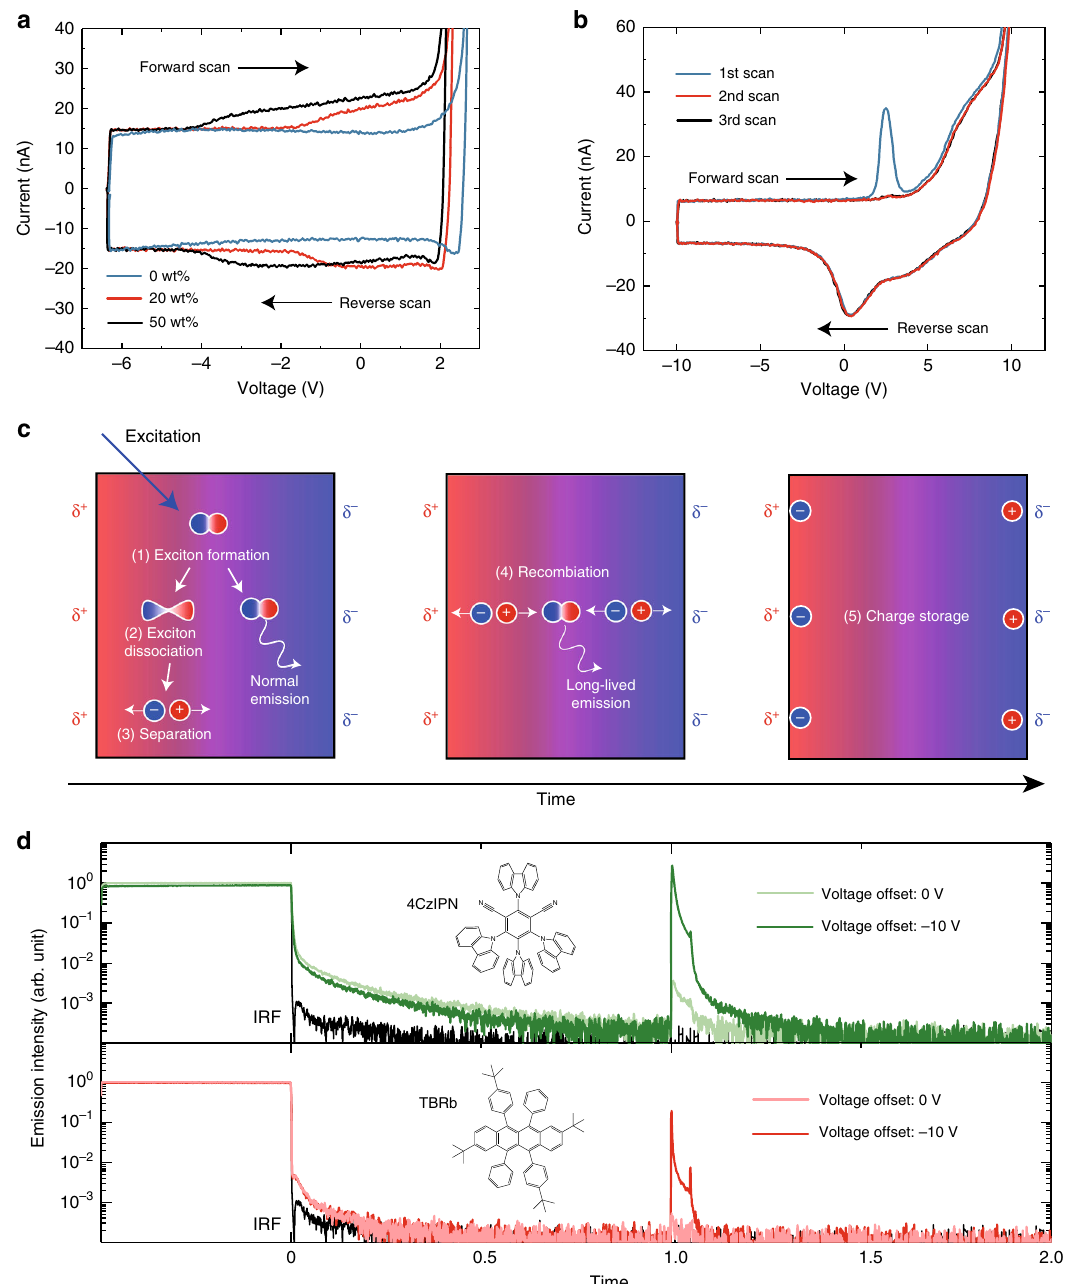
Fig. 3 Displacement current measurements (DCM) and the observation of long-lived emission from other fl uorophores. a DCM pro fi les in OLEDs with EMLs of TPA-DCPP:CBP having different TPA-DCPP doping concentrations. The device structure was ITO (100 nm)/TAPC (50 nm)/EML (30 nm)/T2T (20 nm)/BPy-TP2 (60 nm)/LiF (1.6 nm)/Al (100 nm). b Dependence of DCM pro fi les on the number of scans in non-injecting TPA-DCPP:CBP devices with the structure in Fig. 2a. c Schematic of spontaneous exciton dissociation and recombination processes in solid fi lms containing organic polar fl uorophores. d TRPL pro fi les in non-injecting device based on 50-wt%-TBRb:CBP and 50-wt%-4CzIPN:CBP blend as EML with the structure in Fig. 2a. The black line indicate IRFs. A long PL decay component having a millisecond-order decay lifetime that is much longer than the intrinsic time constant of TADF ( τ d = 4.6 µ s) was observed in the 50-wt%-4CzIPN:CBP blend. In these measurements, a UV-LED with a peak wavelength of 340 nm was used as the excitation light source. Note that the ITO electrode slightly absorbs the excitation light and emits light. The applied peak voltage and the width were fi xed to 5 V and 50 µ s,